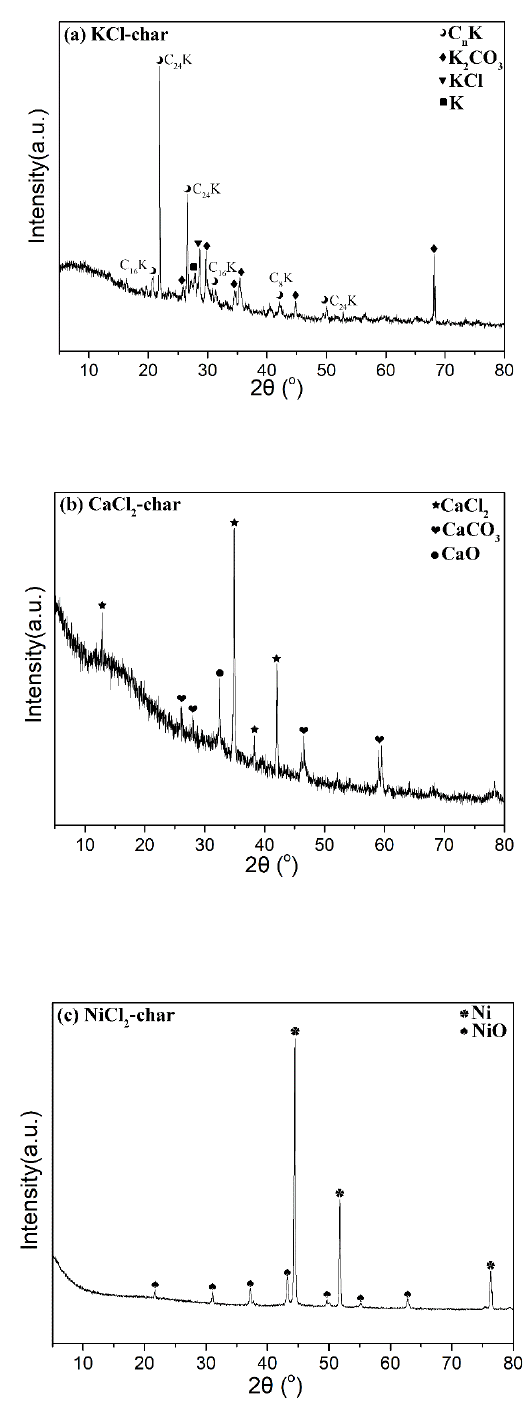
Figure 6. XRD patterns of the studied samples after gasification, ( a ) KCl-char, ( b ) CaCl 2 -char, ( c ) NiCl 2 - char.